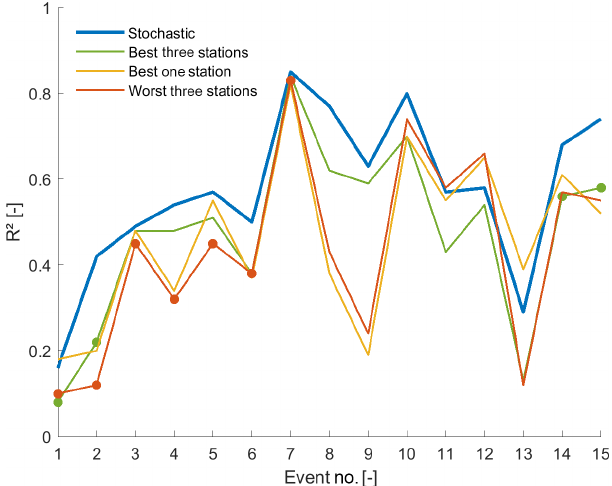
Figure 13. Analysis of 15 rainfall–runoff model events (subset no. 3 in Table 2) with the correlation coefficient between simulated and observed streamflow for different rainfall field inputs, showing the stochastic generation of rainfall fields based on all available rain gauge stations, the best three-stations and the best one-station net- work and the worst three-station network. Larger dots highlight events for which only two of three stations were operational (see Sect. 4.1.1). The lines connect the events to improve